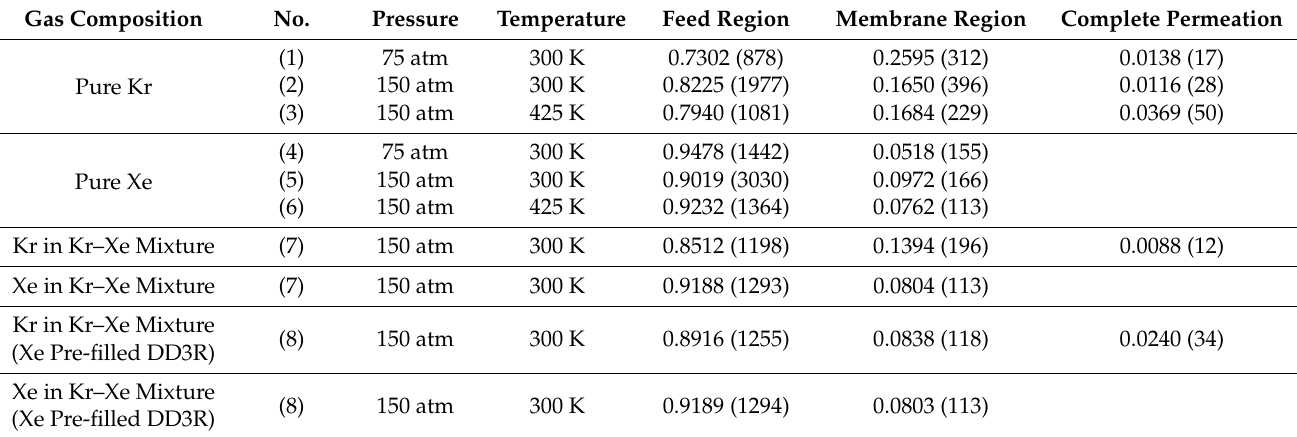
Table 2. Numerical results of 30 ns NVT gas permeation system